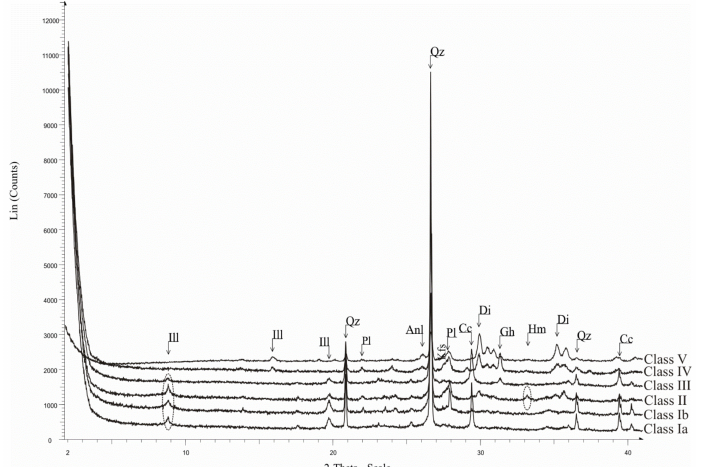
Figure 9. Composite graph displaying representative diffractograms of each class. Abbreviations: Qz = quartz, Di = diopside, Gh = gehlenite, Kfs = k-feldspar, Pl = plagioclase, Ill = illite, Hm = hematite, Anl = analcime. Dashed circles show the illite and hematite